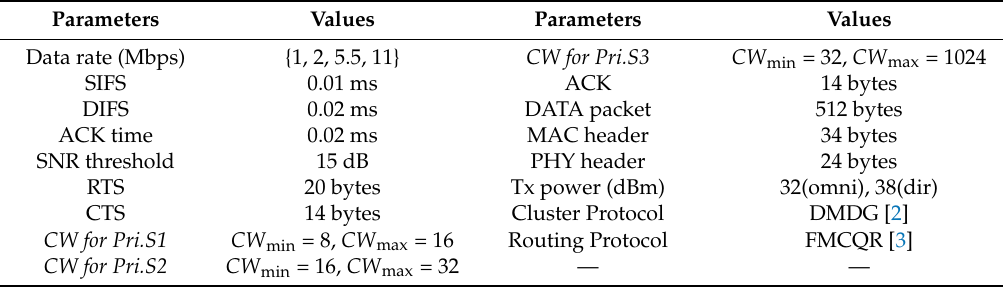
Table 3. Analytical parameter